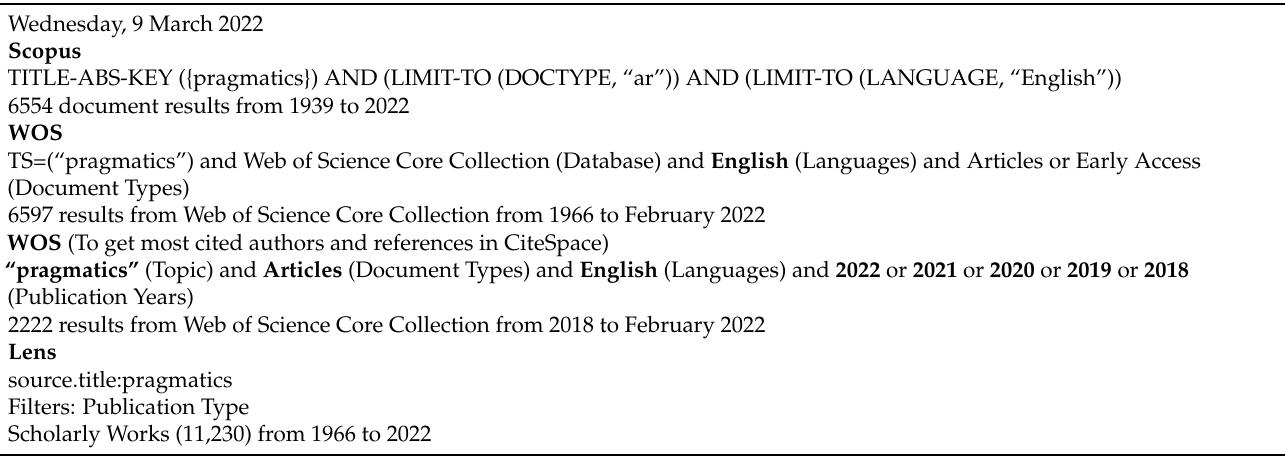
Table 2. Search strings for retrieving data on pragmatics from Scopus, WOS and